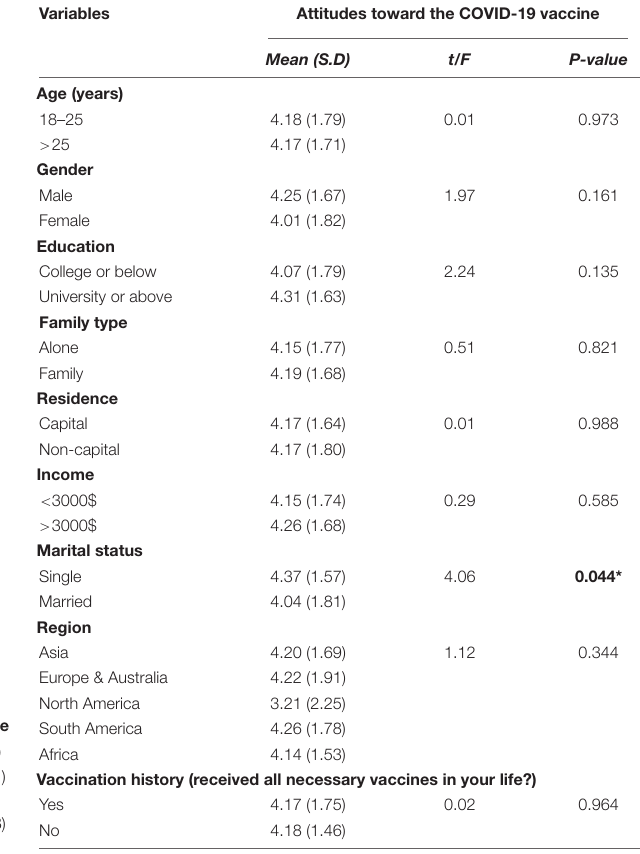
TABLE 2 | Group difference analysis with attitudes toward COVID-19